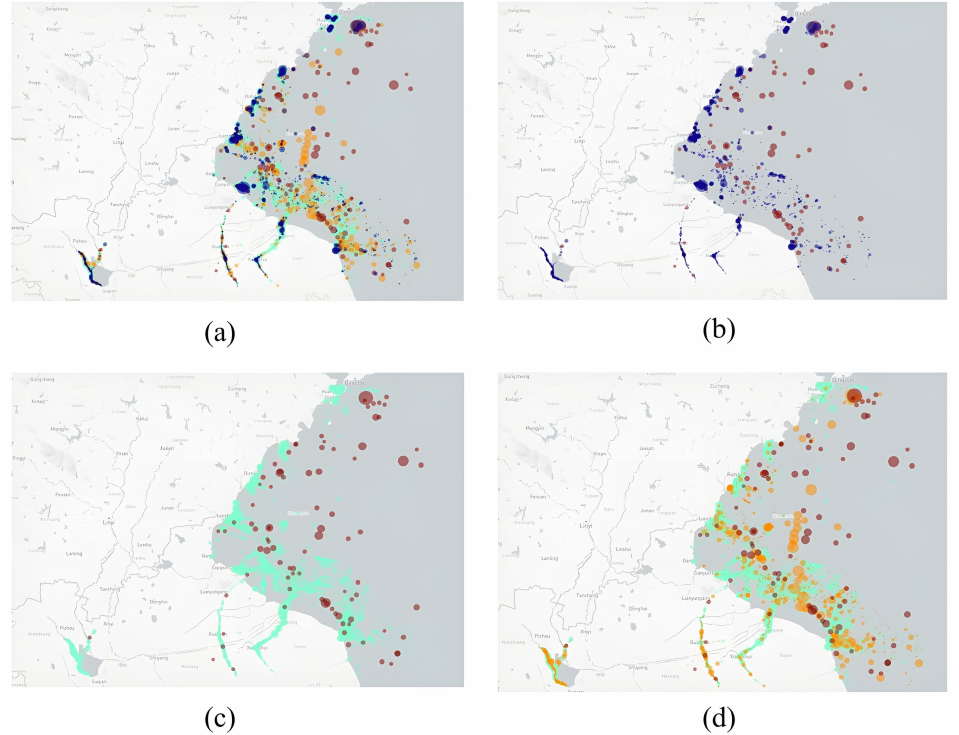
Figure 10. Visualization of suspected illegal transshipment identification results: ( a ) High/Medium/ Low/Fixed threshold; ( b ) High/Fixed threshold; ( c ) High/Low; ( d ) High/Medium/Low (High-red bubble, Medium-yellow bubble, Low-sky blue bubble, Fixed threshold-dark blue